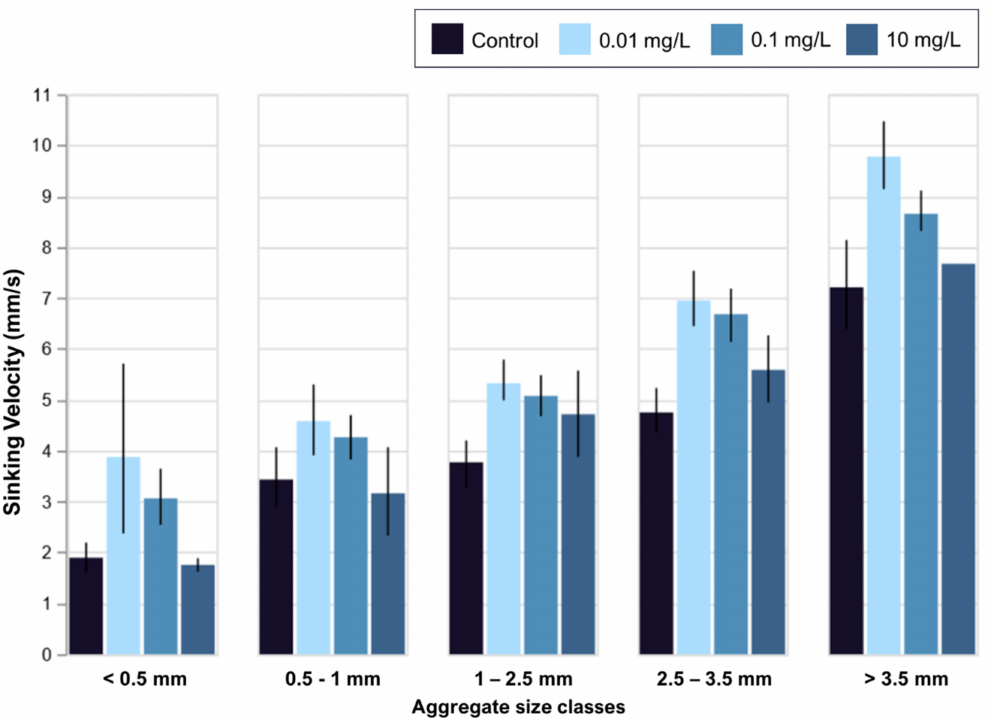
Figure 3. Sinking velocity change with nanoPS exposure. Sinking velocities decrease with aggregate size from more than 7 mm / s ( > 3.5 mm) to less than 2 mm / s ( < 0.5 mm). In all class sizes, the control was similar in sinking velocity to the highest nanoPS treatment (10 mg / L). The low nanoPS treatment (0.01 mg / L) di ff ered significantly from both controls ( t -test, two-tailed p = 5.56 × 10 − 4 ) and the highest nanoPS treatment ( t -test, two-tailed p = 9.03 × 10 − 4 ). This was also true for the intermediate nanoPS treatment (darker blue, 0.1 mg / L). Error bars are 95% confidence intervals. Only one huge aggregate was measured in the highest nanoPS treatment. No di ff erences in sinking velocity were observed